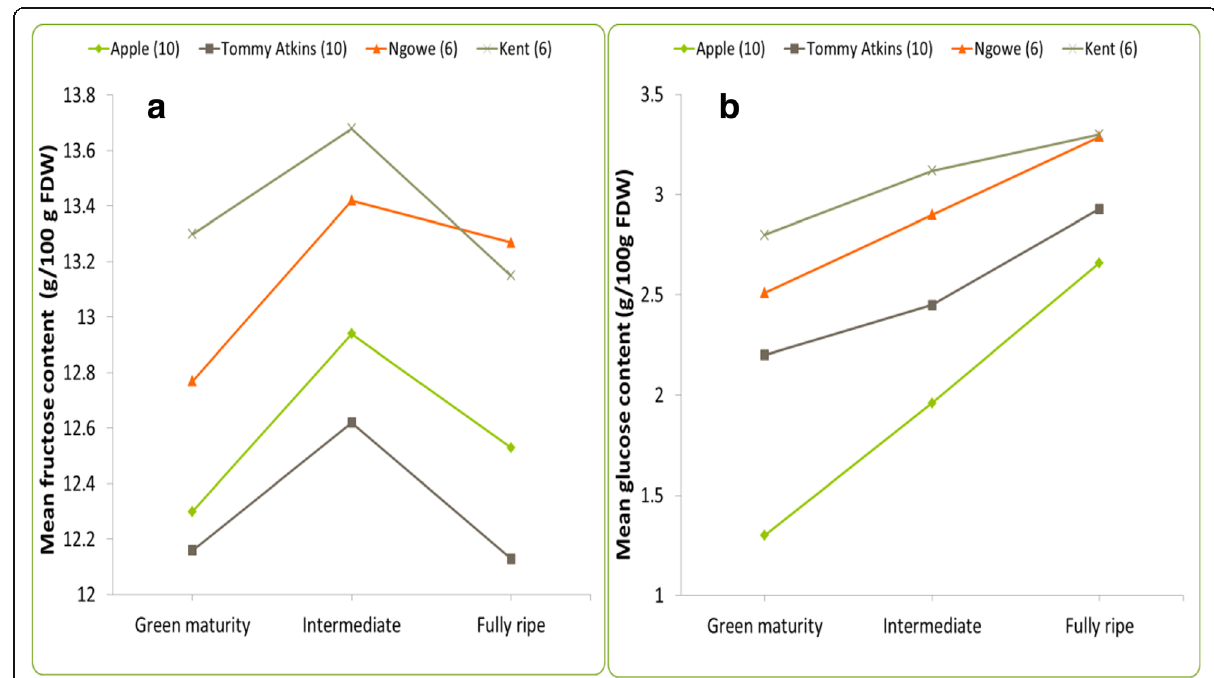
Fig. 6 General trend of changes in mean fructose and glucose contents of mango cultivars at different ripening stages in KARI-Thika Site